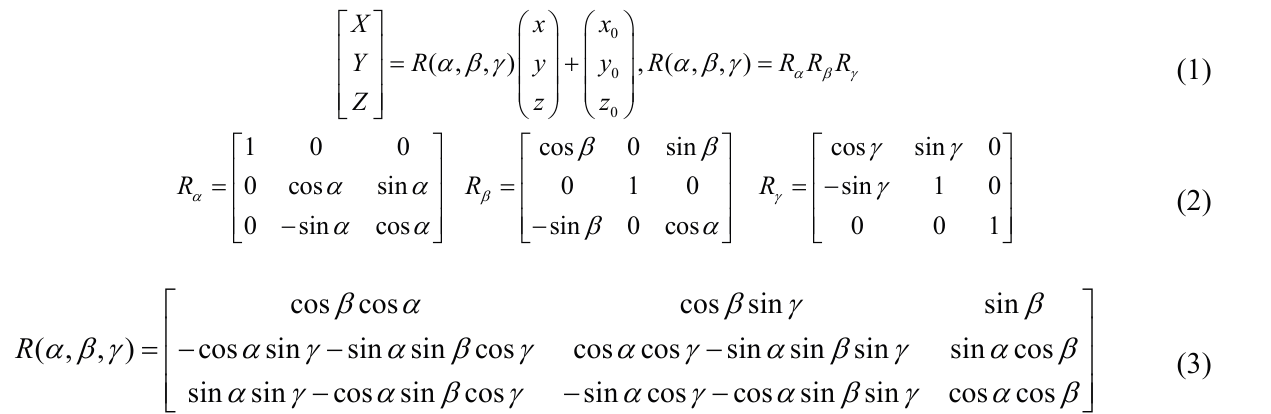
to the best transformation matrix R 1 and T 1 (Figure 2; green circles are terrestrial corners, and black triangles are airborne